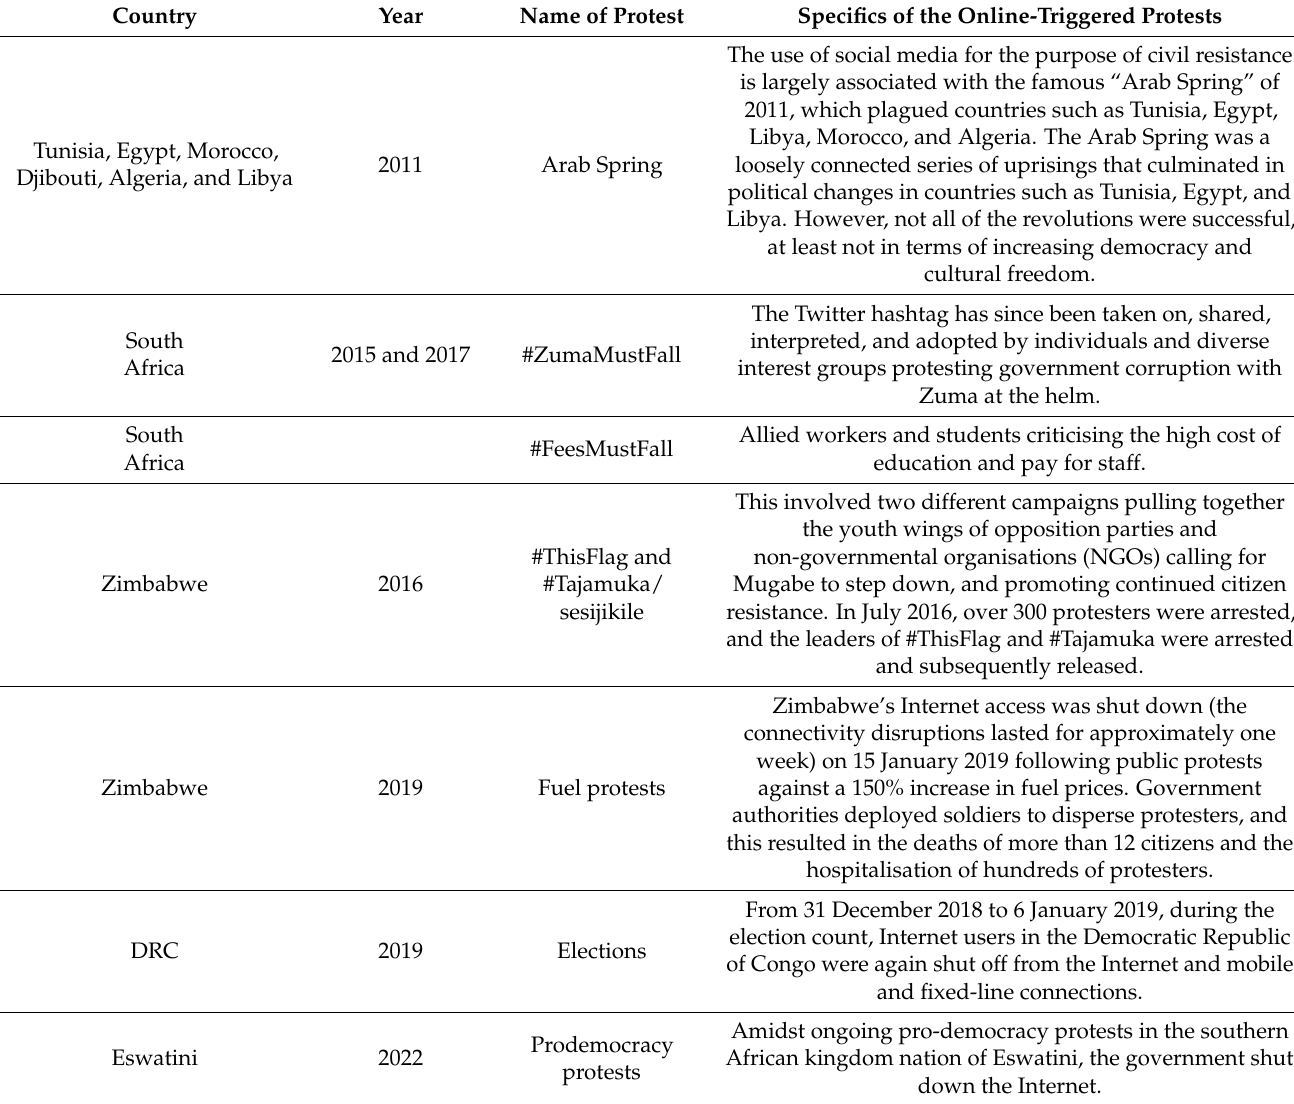
Table 1. Digital disruption of human rights in selected SADC